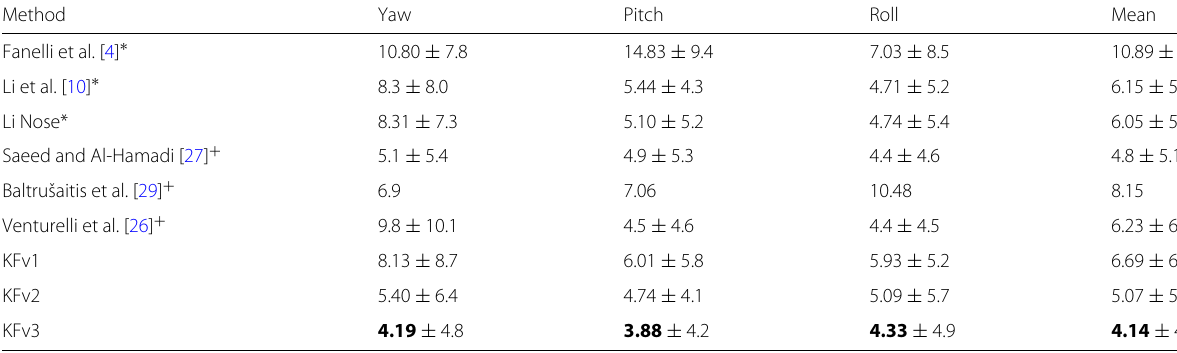
Table 4 Results on ICT-3DHP dataset in Euler angles